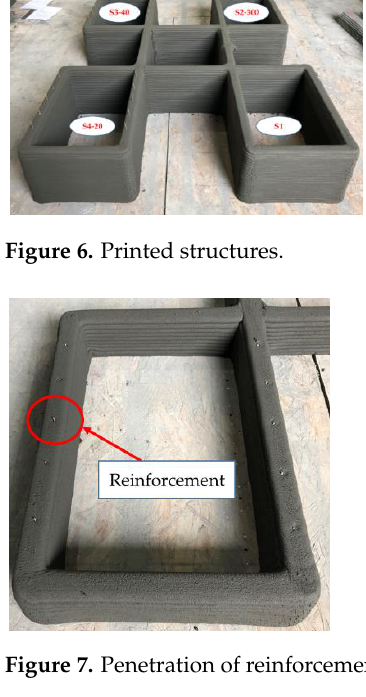
Figure 5. Details of the locations of reinforcements and extractions in mortar specimens. ( a ) S1; ( b )